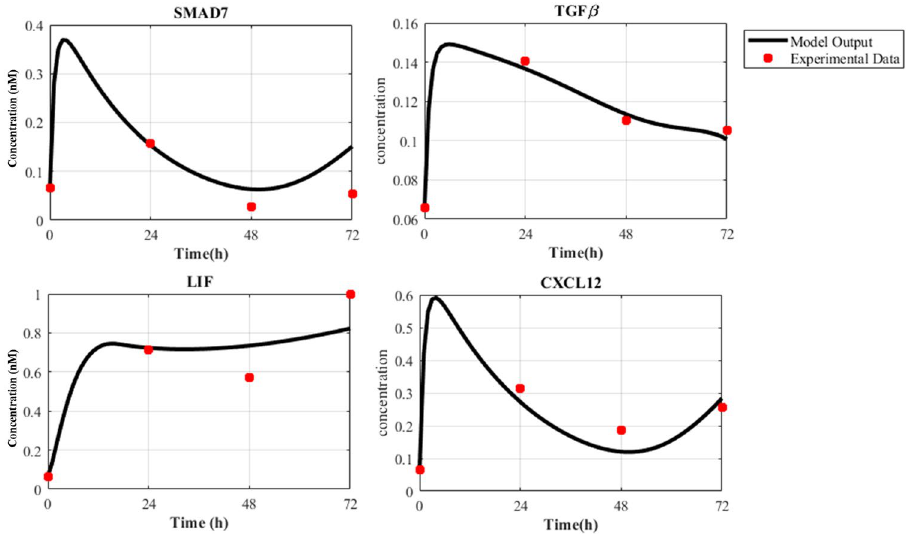
Figure 7. Experimental data and model outputs of ODE modeling of CAF. Gene expression profiles of SMAD7, TGFβ, LIF, and CXCL12 molecules in CAF over four time points (0, 24, 48, and 72 h) and their corresponding behavior in the dynamic model are depicted by red dots and black curves,